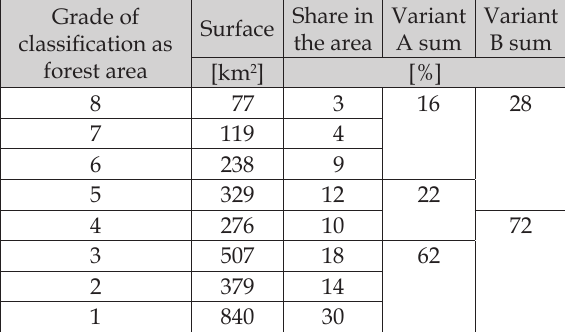
Table 2. Variants of the hypothetical forest area in 13th-century Chełmno Land. Grade of classification as forest